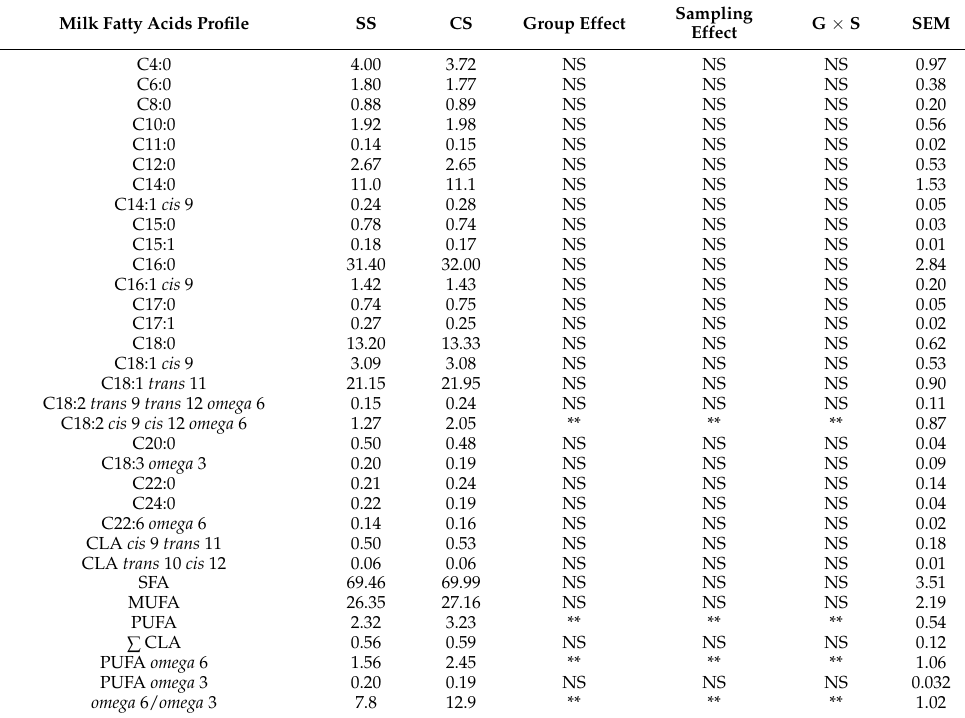
Table 5. Milk fatty acid profile (% total fatty